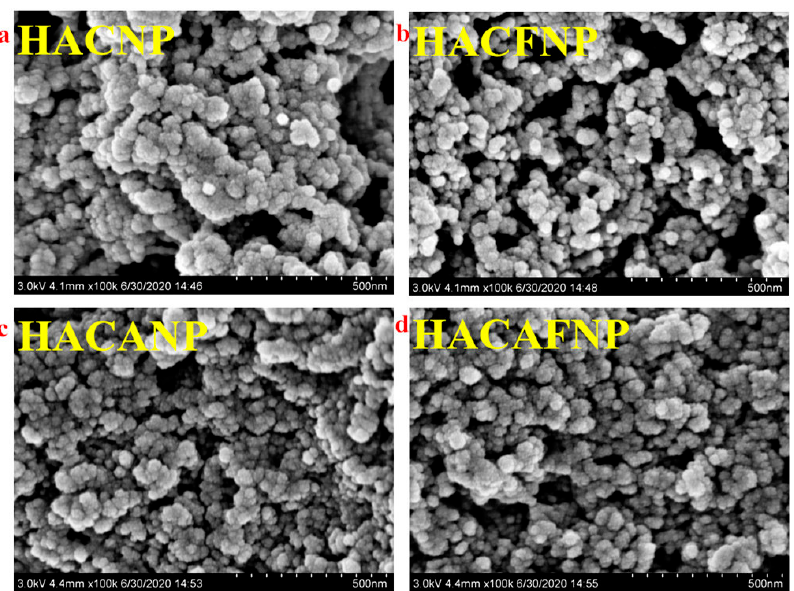
Figure 4. SEM images of chitosan nanoparticles ( a ) HACNP, ( b ) HACFNP, ( c ) HACANP, and ( d ) HACAFNP.